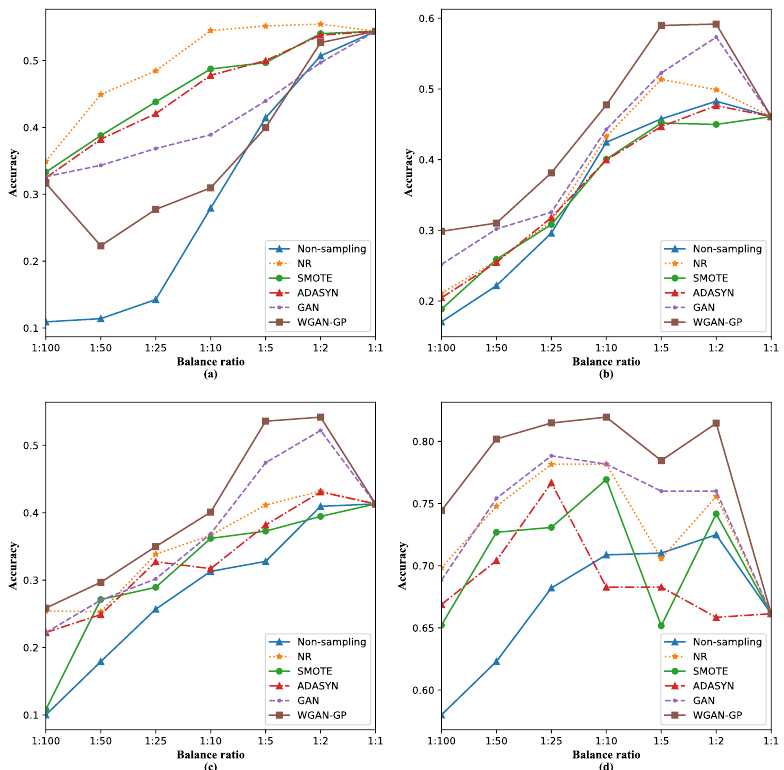
Figure 8. Diagnosis accuracy of multi-class imbalance fault dataset on HP = 3 and SNR = 10 dB: ( a ) SVM model; ( b ) BP model; ( c ) DBN model and ( d ) CNN